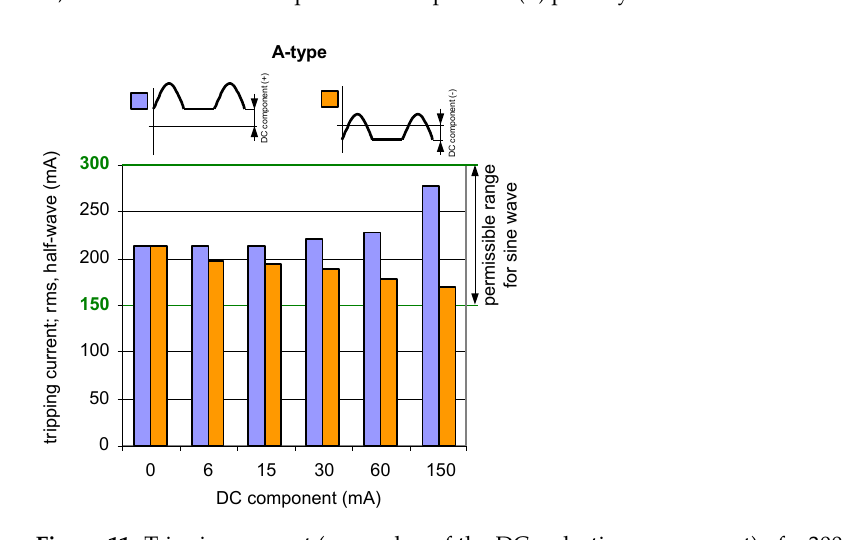
Figure 10. Tripping current (rms value of the DC pulsating component) of two 100 mA A-type RCDs under pulsating DC (half-wave) current superimposed by smooth DC component of values 6, 15, 30, 60, and 150 mA. Both components have positive (+) polarity.